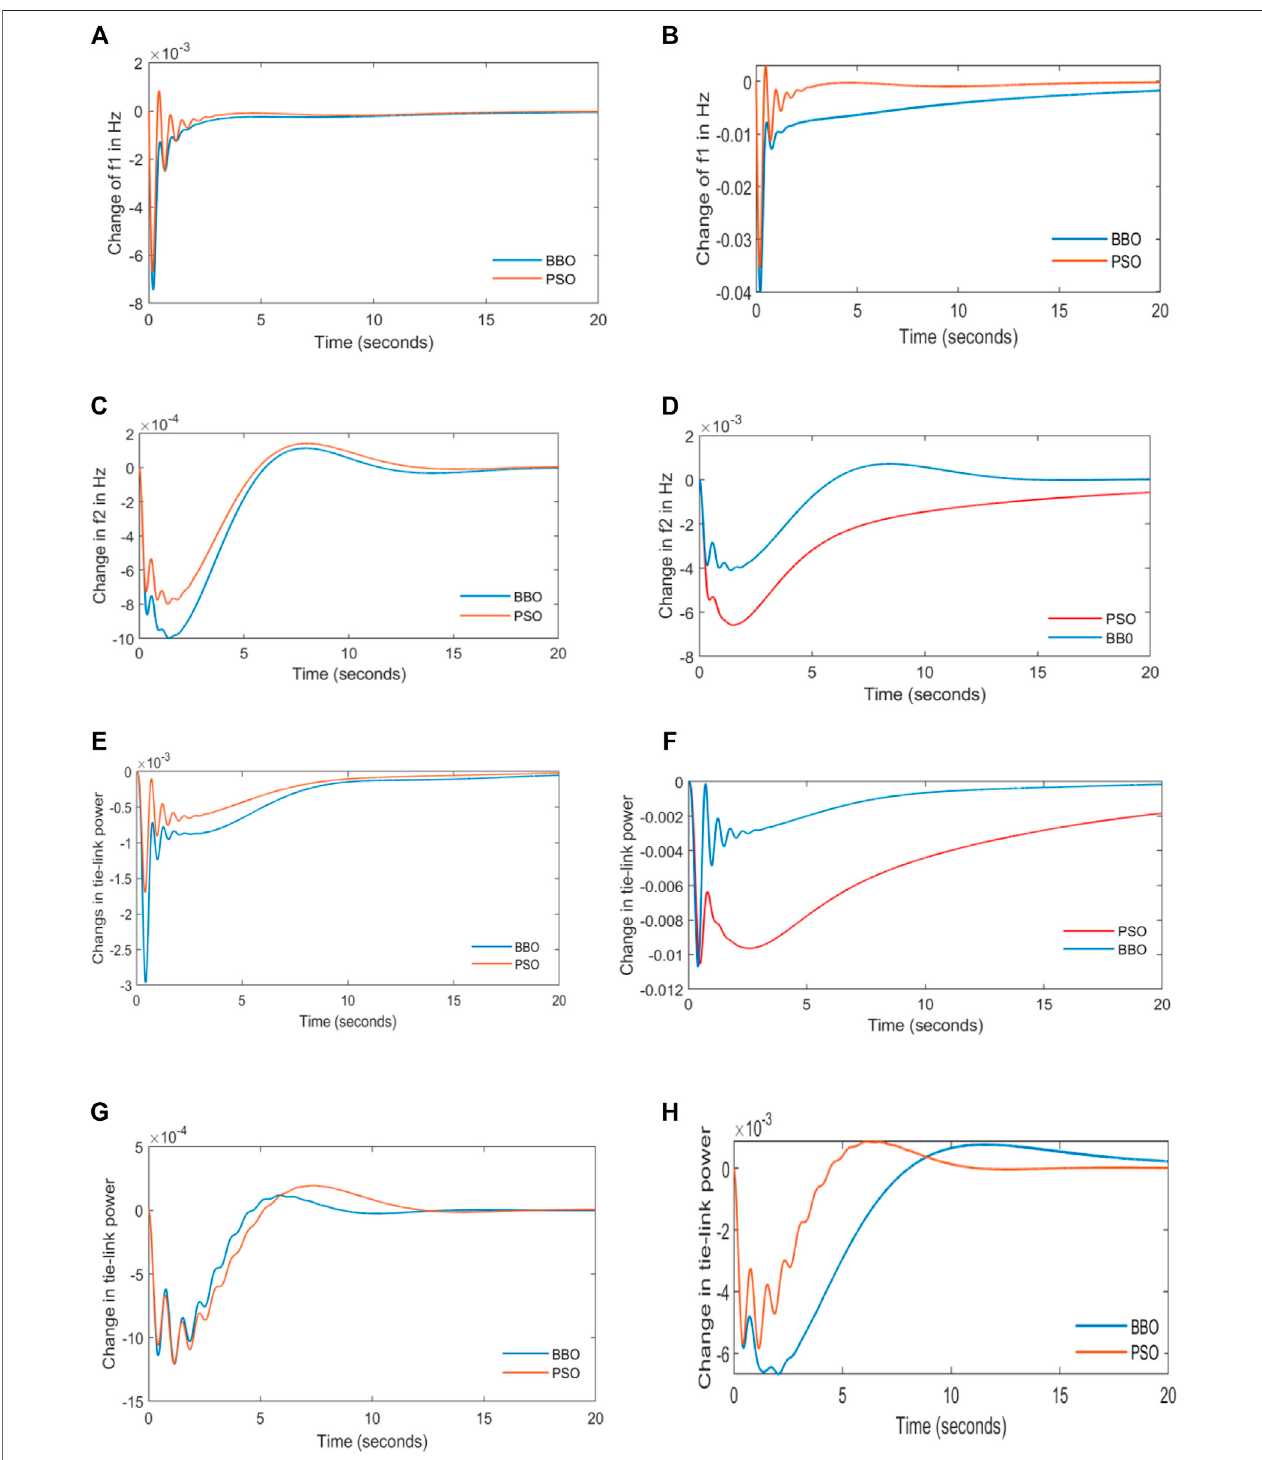
FIGURE3| DynamicsofArea-1andArea-2withandwithoutHESSfor1%and5%changeinloadwithVSP-HVDClink. (A) Dynamicsoff 1 at1%LoadChangewith HESS. (B) Dynamics of P tie at 1% Load Change with HESS. (C) Dynamics of f 2 at 1% Load Change with HESS. (D) Dynamics of f 1 at 5% Load Change with HESS. (E) Dynamics of P tie at 5% Load Change with HESS. (F) Dynamics of f 2 at 5% Load Change with HESS. (G) Dynamics of P tie at 1% Load Change without HESS. (H) Dynamics of P tie at 5% Load Change without